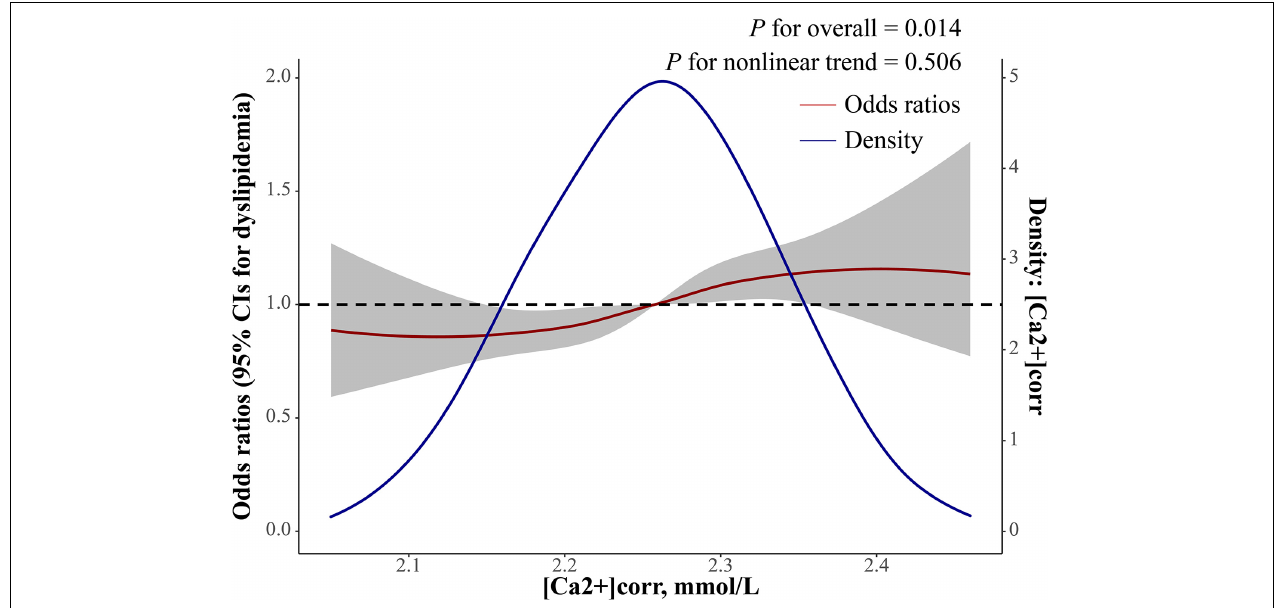
FIGURE 2 | Dose-response relationship between [Ca2+]corr and dyslipidemia odds. The red line with a 95% confidence band is multivariate-adjusted odds ratios using a restricted cubic spline regression with four knots with a polynomial smoother. The blue line is a kernel density plot of [Ca2+]corr. [Ca2+]corr, corrected serum ionized